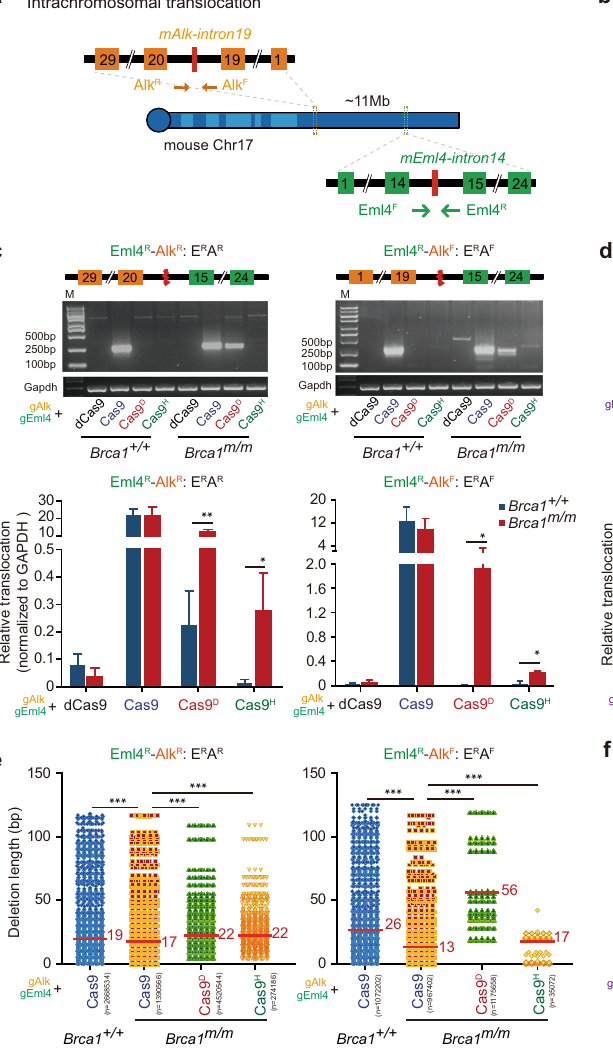
translocation reads to Gapdh reads and normalized by transfection ef fi ciencies (bottom).Thefoldofincreasebetween Brca1 +/+ and Brca1 m/m cellsisindicatedabove each column. e , f Deletion length at the junctions of Eml4 – Alk translocations E R A R and E R A F ( e ) and Rosa26 – Ldha translocations R R L F andR F L F ( f ) between Brca1 +/+ and Brca1 m/m mESC. The median length is indicated. Total reads ( n ) for translocations are indicated under Cas9 or nCas9 in parenthesis. Each dot represents 500 reads. Columns indicate the mean ± S.E.M from three independent experiments. Statis- ticalsigni fi canceisdetectedbytwo-tailedStudent ’ s t test.Tocomparethedeletion distribution between each sample, two-tailed Mann – Whitney test is performed. * P <0.05; ** P <0.01 and *** P